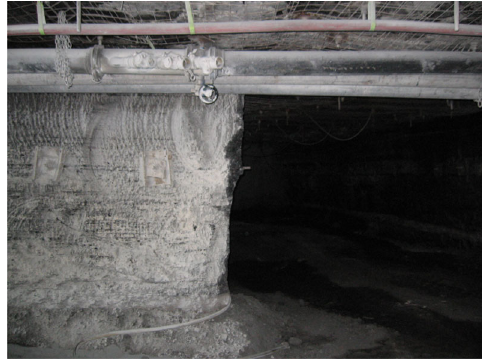
Fig. 5 Sensor suite on the test platform, radar enclosure on the right Fig. 6 Cluttered rib wall and